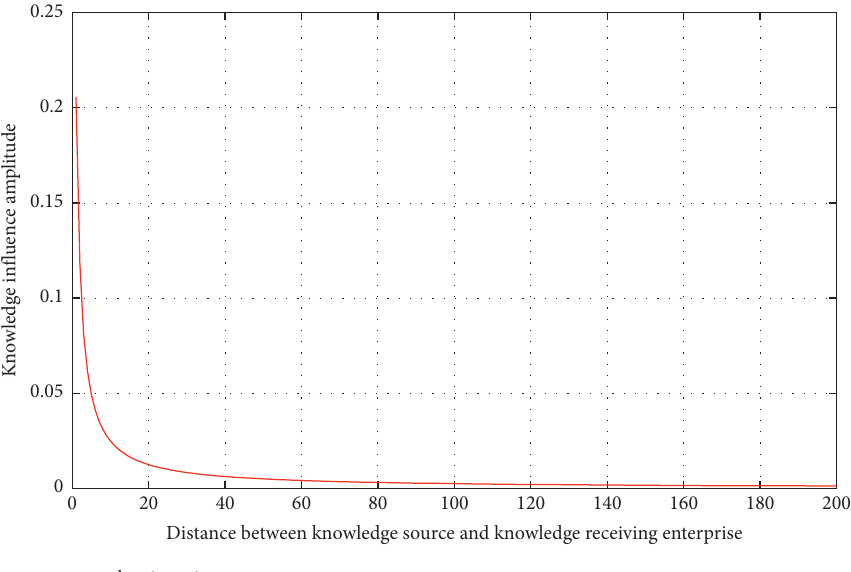
Figure 5: Distribution of knowledge influence intensity in the knowledge